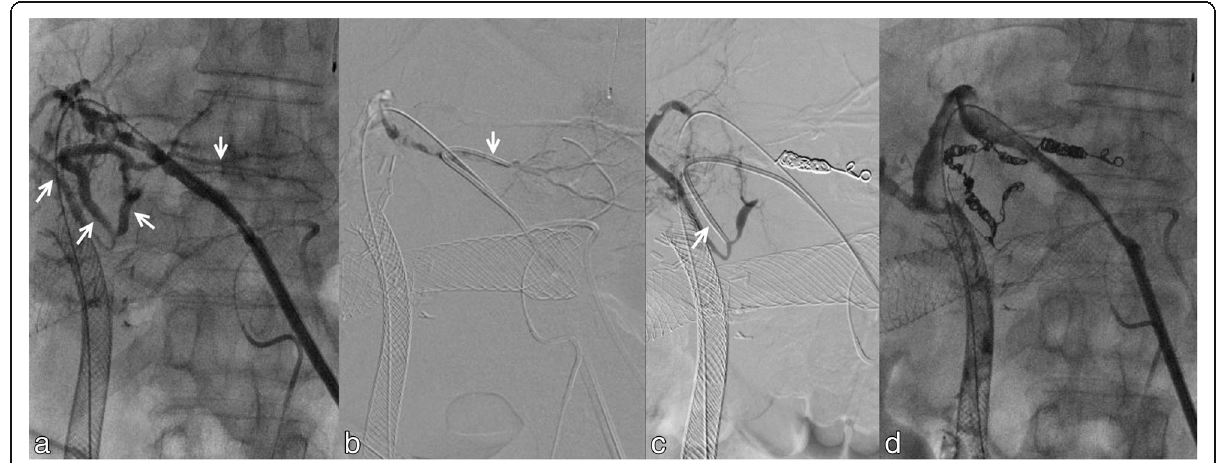
Fig. 3 Sheath cholangiogram ( a ) shows lateral segment hepatic artery branches (short arrows). The segment 3 artery is cannulated both distal ( b ) and proximal ( c ) to the arteriobiliary fistula for coil embolization. Final sheath cholangiogram ( d ) shows resolution of flow in lateral segment arteries from the segment 3 bile